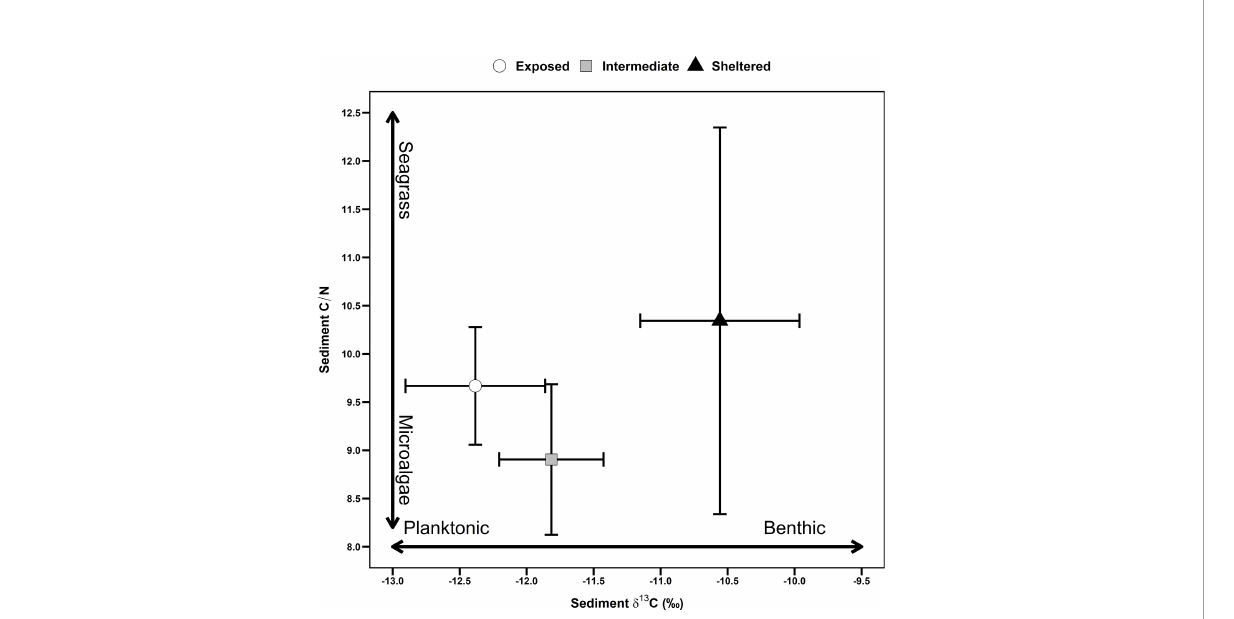
FIGURE 3 Spatial variation in C:N ratio and carbon stable isotope ( d 13 C) values of the sediment sampled in sheltered (triangle), intermediate (square) and exposed (circle) intertidal fl ats in Banc d ’ Arguin, Mauritania. Ratios are calculated per subsample (n = 25 per site) and the mean ± standard deviation is estimated per